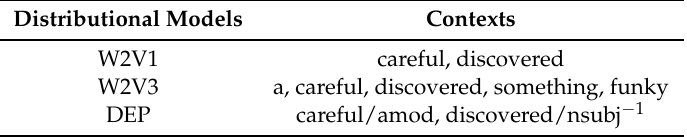
Table 1. Contexts extracted by different models: W2V1, W2V3, dependency-based word embedding (DEP).